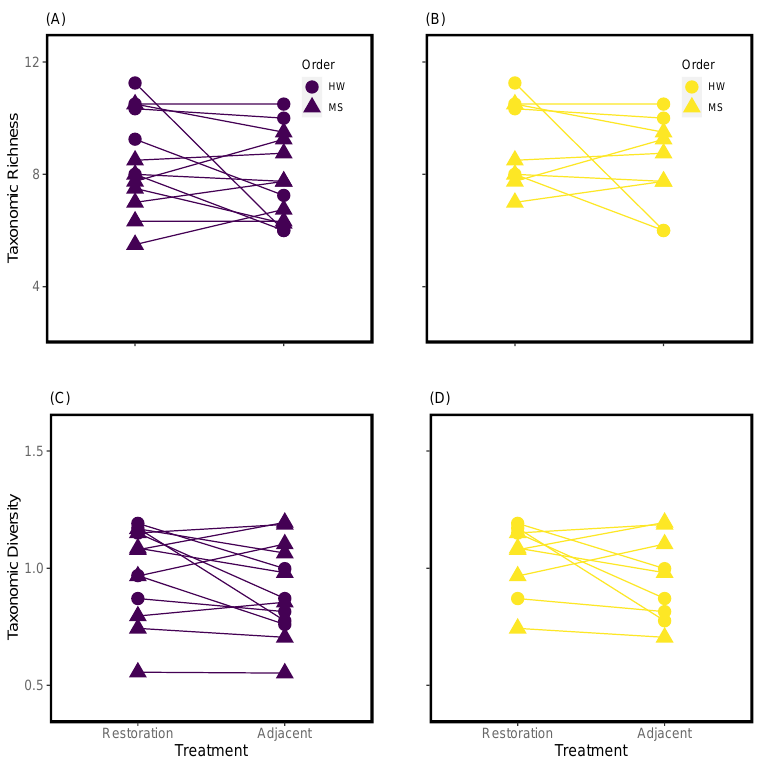
Figure 5 : Plots of taxonomic richness (A and B) and diversity (C and D) for restored and adjacent reaches of each site. Lines connect values for each site. Values from the full sites are reported in purple (A and C), while values from the revised sites are reported in yellow (B and D). Points represent the mean taxonomic richness or diversity. Error bars are not presented to improve graphical